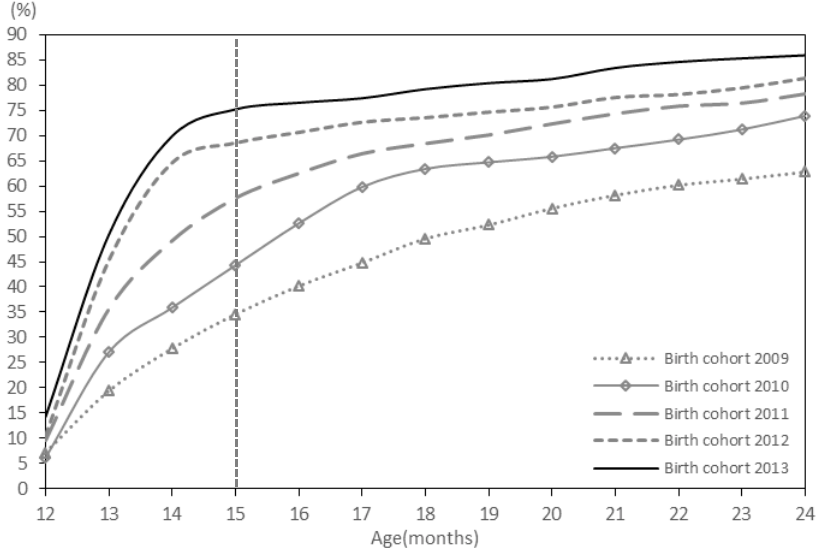
Figure 1. The coverage rate of VarV 1 for children aged 2–6 years.